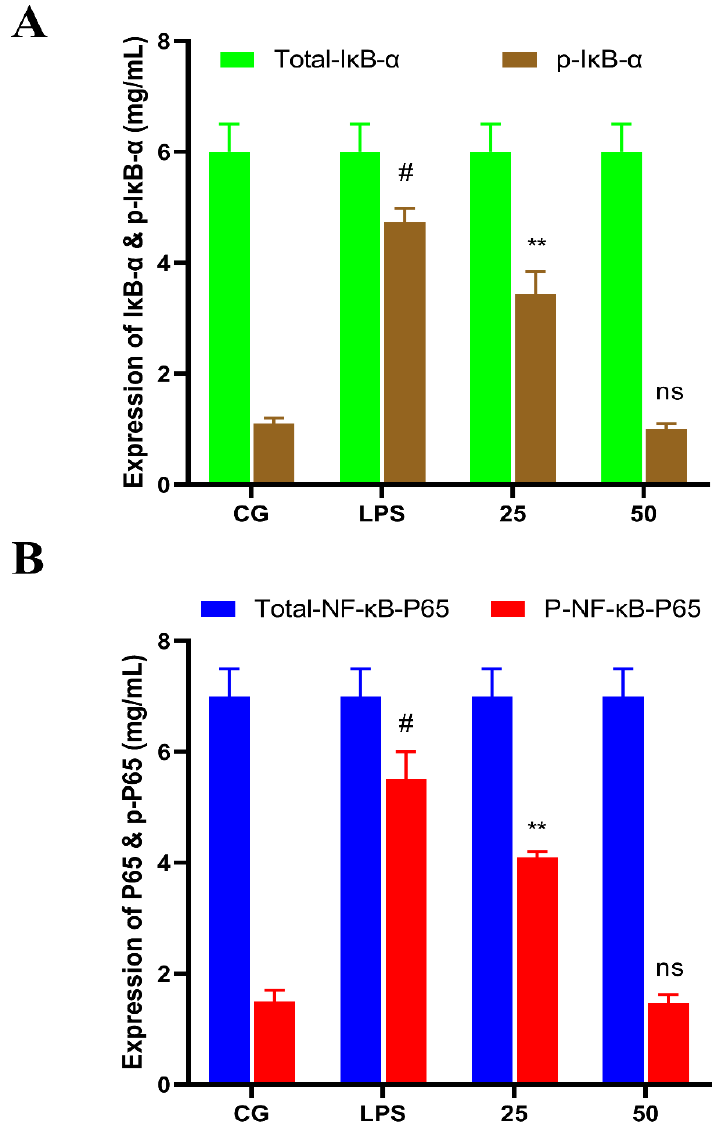
Figure 7. Effects of GnRb1 against LPS-induced expression NF- κ B pathway proteins measured by ELISA. ( A ) The expression levels of the NF- κB p65 and its phosphorylated (p -NF- κB p65) form. ( B ) The expression levels of total I κBα and its phosphorylated (p-I κBα ) form. CG represents the control group. LPS reveals the LPS-induced groups. The 25 and 50 are the GnRb1-administrated groups representing 25 mg/kg and 50 mg/kg per animal, respectively. GnRb1 indicates the Ginsenoside Rb1. Data statistics are demonstrated as mean ± S.E.M. The # p < 0.001 CG versus LPS group, ** p < 0.01, and ns indicates the nonsignificant difference between CG versus LPS + GnRb1 groups.